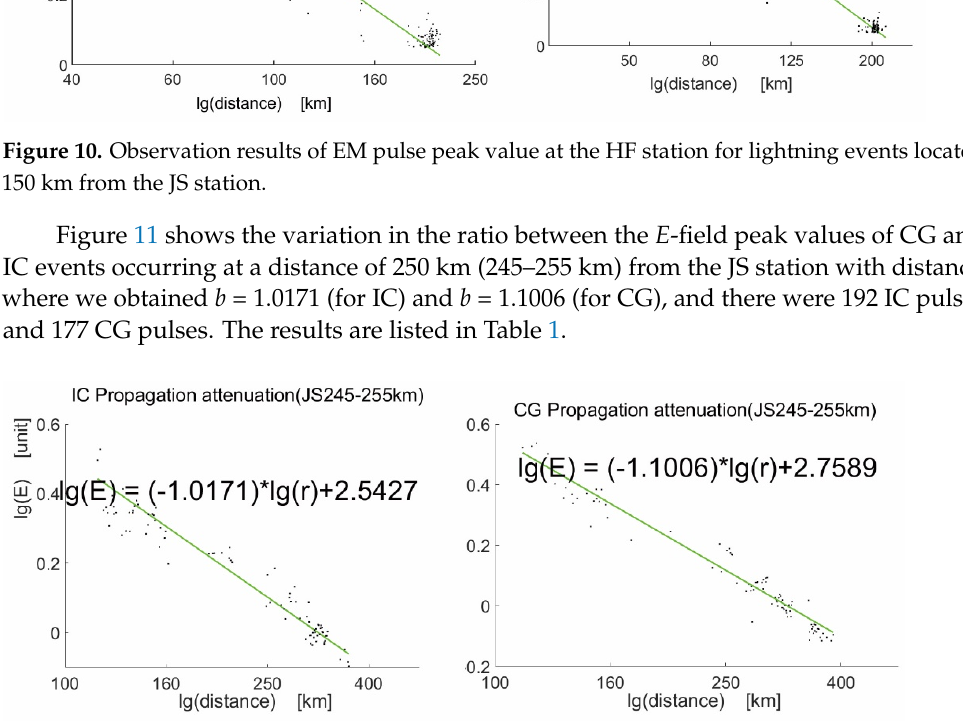
Table 1. Variation in the E-field peak values of CG and IC events with distance from the HF sta- tion.